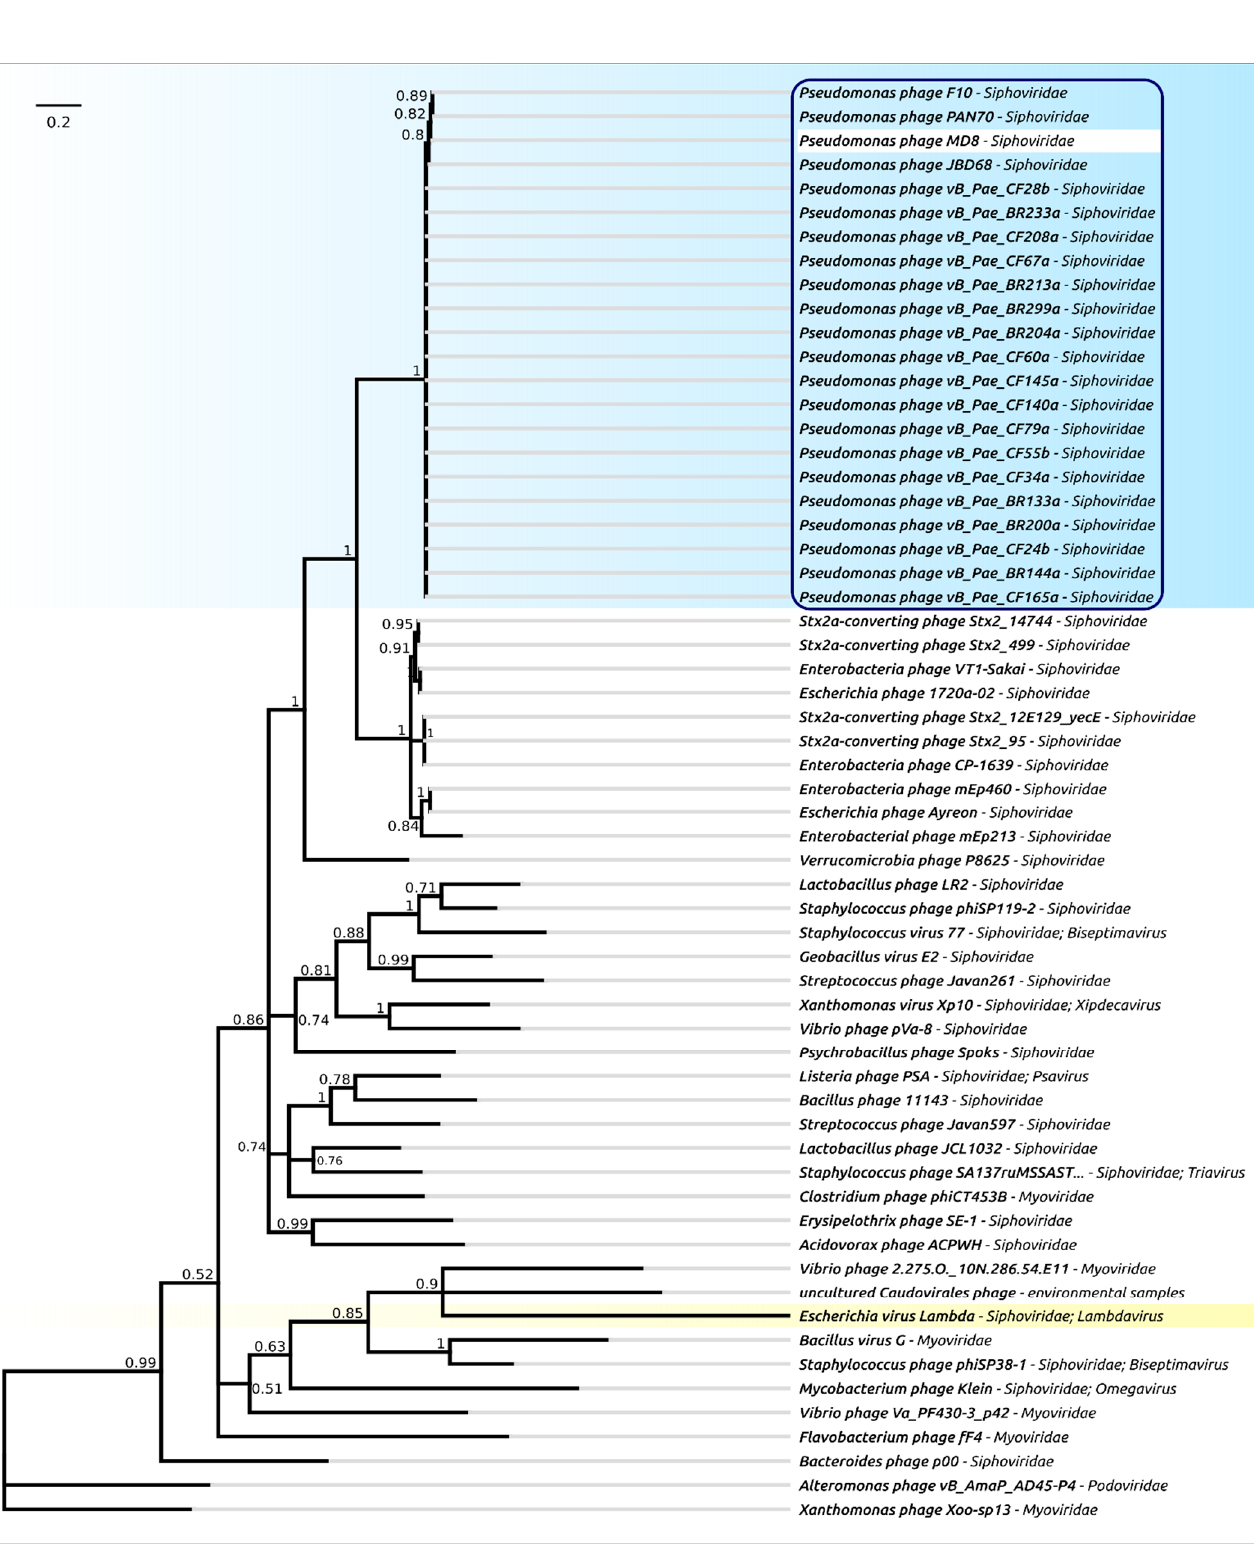
Figure 7. Phylogenetic tree obtained with MRBAYES, based on protease domain amino acid sequences. Bayesian posterior probabilities are indicated near their branches. The taxonomic classification is shown to the right of the phage’s name. The scale bar shows 0.2 estimated substitutions per site and the tree was rooted to phage Xanthomonas phage Xoo-sp13. The chain length was 2,200,000, the burn-in length was 200,000, the subsampling frequency was 200 and the average standard deviation of split frequencies was 0.011.